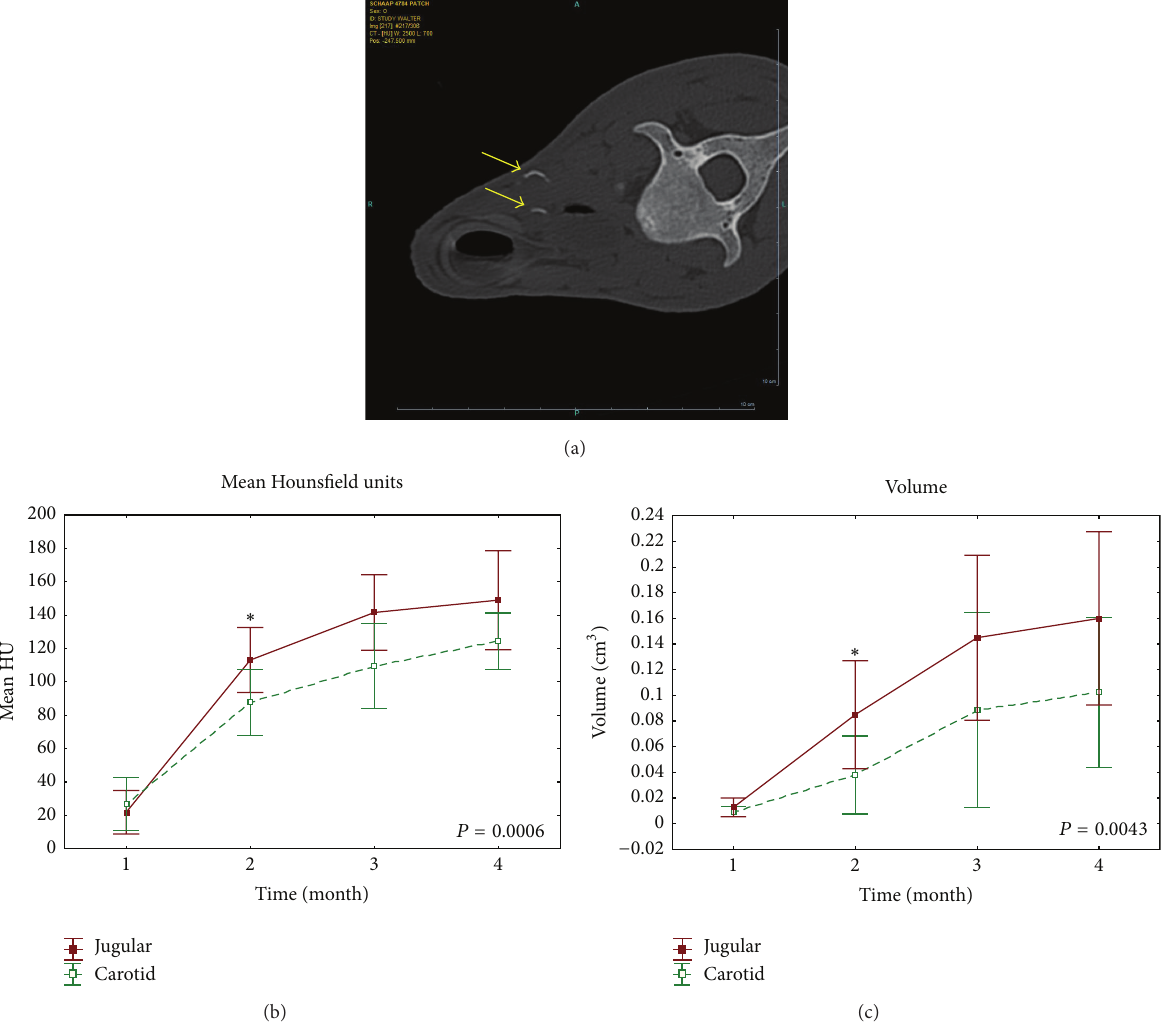
Figure 3: (a) shows a representative example of the CT scan obtained in the patch model at 4 months. Calcification of the patches in both venous position (upper arrow) and arterial position (lower arrow) is visible. (b) and (c) show the evolution of mean HU and mean calcium volume over time, in both the venous and arterial